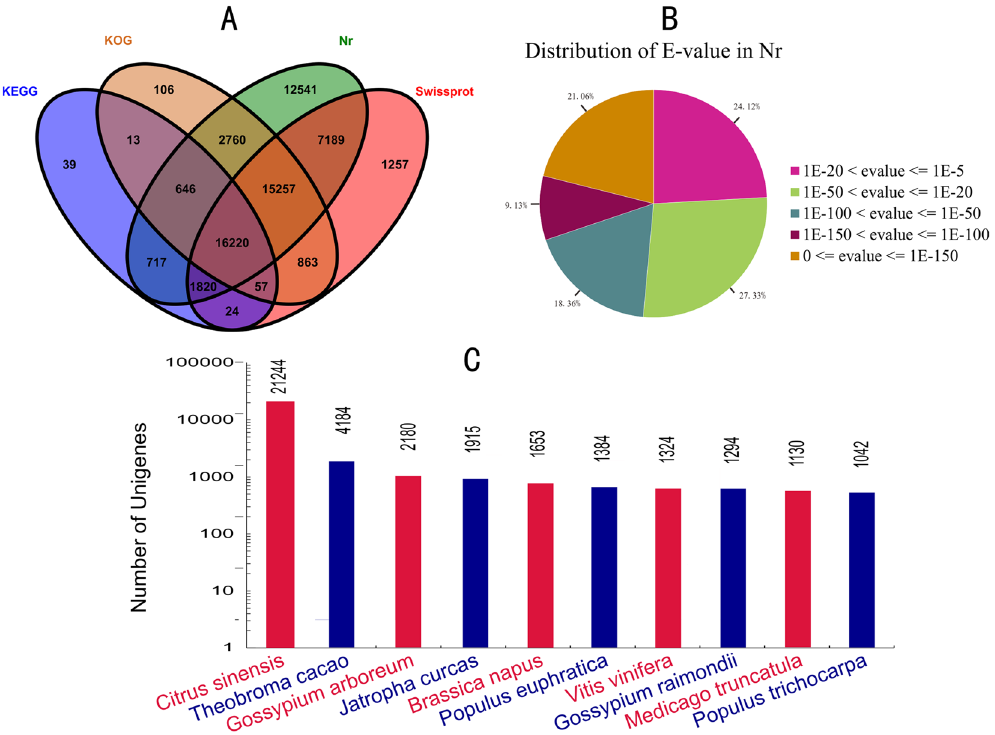
Figure 2. Characteristics of homology search of zanthoxylum unigenes. ( A ) Venn diagram of number of unigenes annotated by BLASTx with a cut-off E-value 1e − 05 against protein databases. Numbers in the circles indicate the number of unigenes annotated by single or multiple databases; ( B ) E-value distribution of the top BLASTx hits against the nr database; ( C ) Number of unigenes matching the 20 top species using BLASTx in the nr